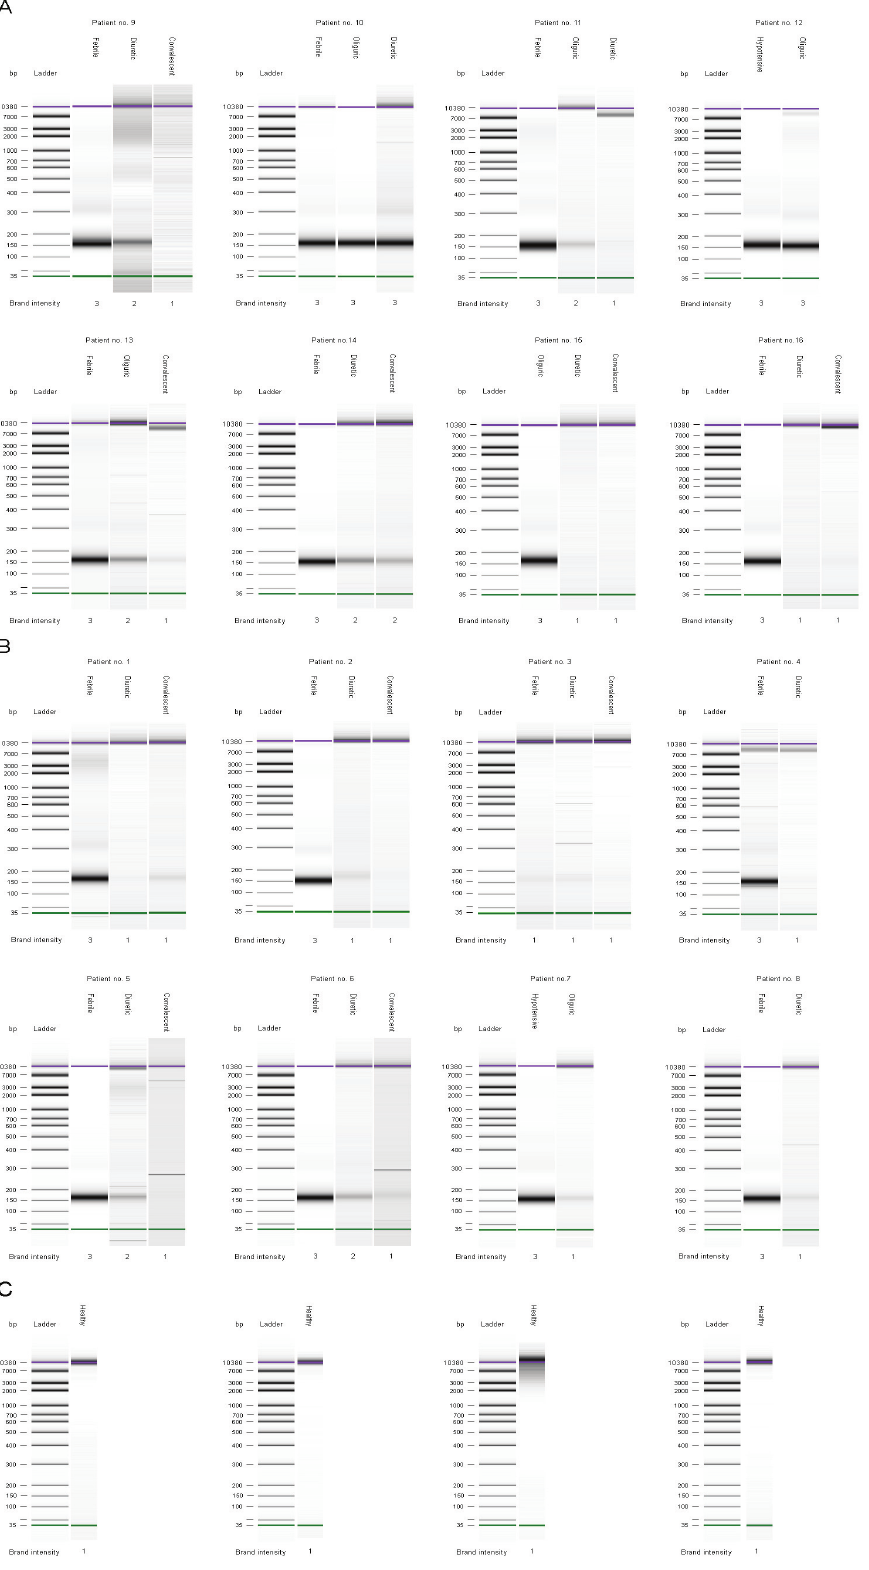
Figure 3. Qualitative analysis of plasma cf-DNA in eight severe/critical patients ( A ); eight mild/moderate patients ( B ); and four healthy controls ( C ) after NucleoSpin Plasma XS kit extraction. The lower, thin solid lines indicate the low weight (35 bp) DNA marker and the upper thick solid lines indicate the high weight (10,380 bp) DNA